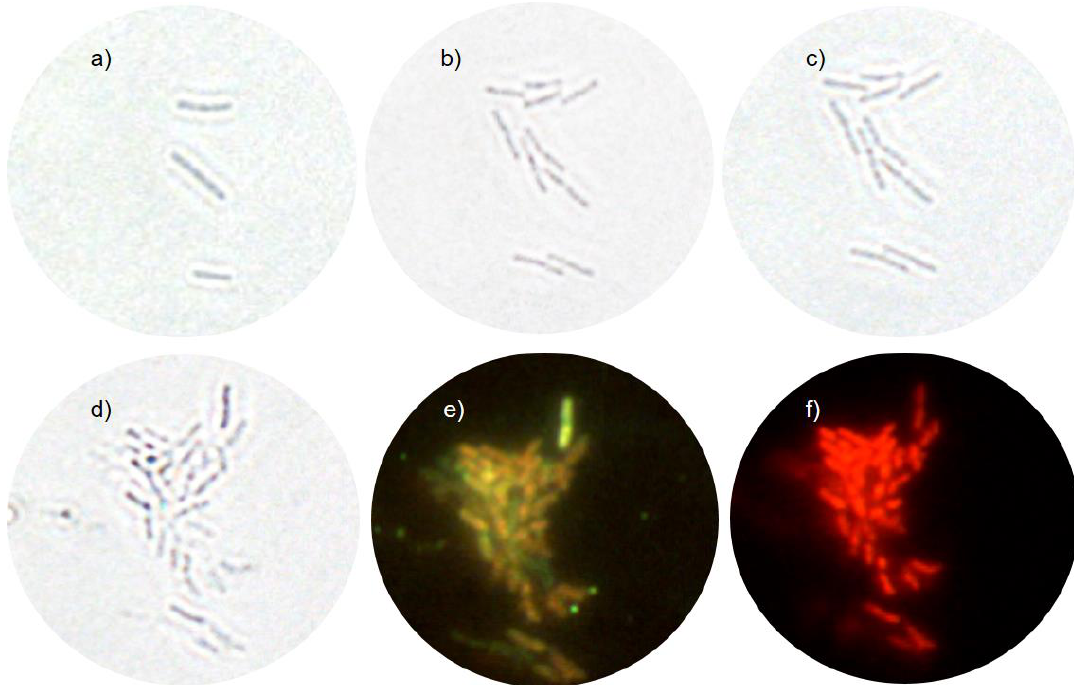
Figure 5. Optical microscopy data of non-treated and treated E. coli cells . ( a ) Bright-field image of the initial “mother cells” before AFM imaging. ( b ) Bright-field image taken after AFM of non-treated cells, about 1.5 h after the ( a ) image. ( c ) Bright-field image taken after a few minutes of treatment. ( d ) Bright-field image taken after 3 h of treatment. ( e ) SYTO 9 fluorescence image taken after 3 h of treatment. ( f ) PI fluorescence image taken after 3 h of treatment.